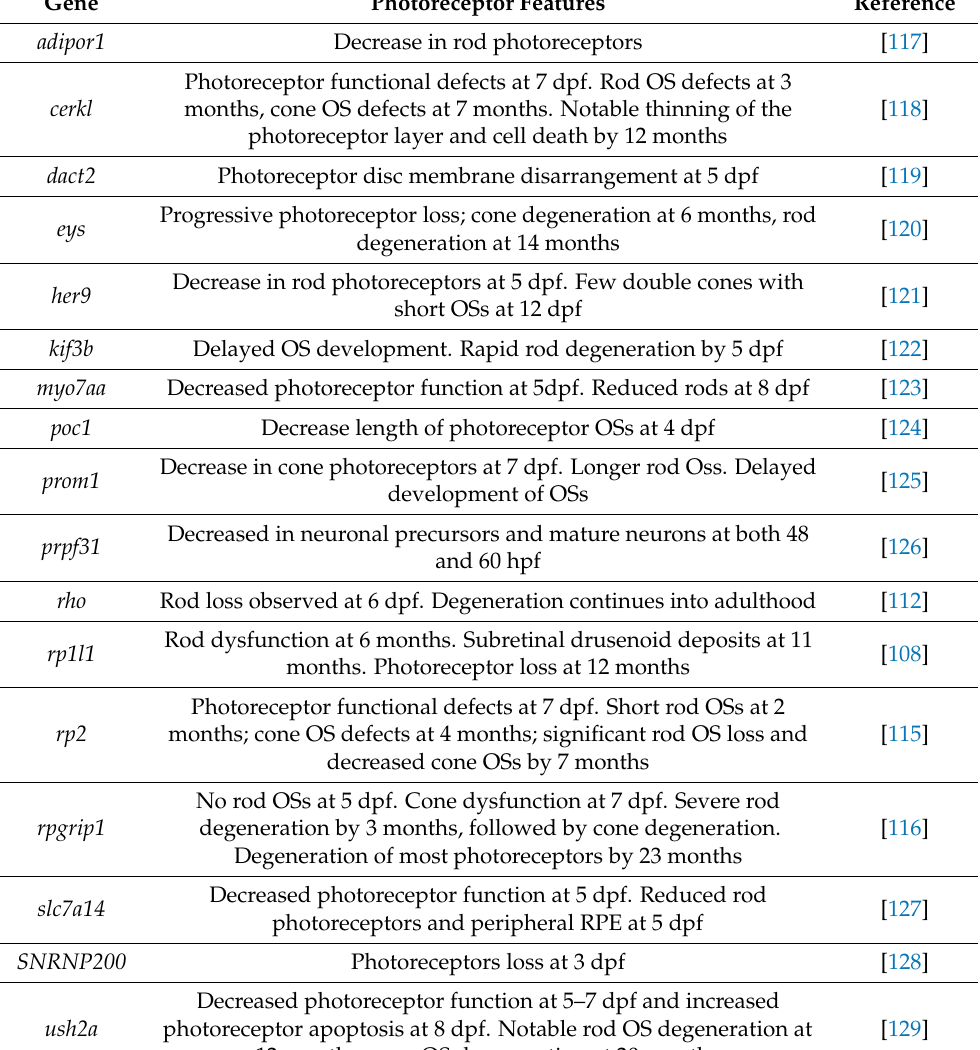
Table 3. Zebrafish models of retinitis pigmentosa-like